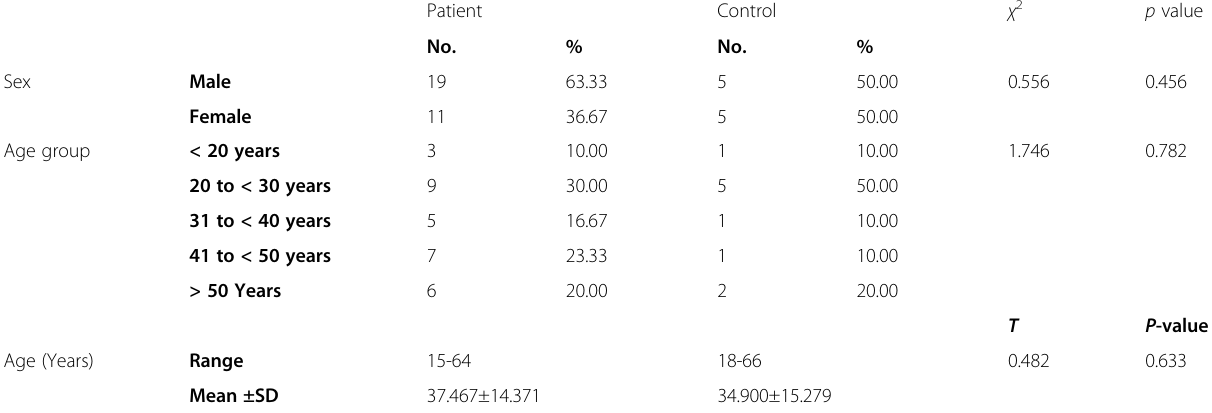
Table 2 Distribution of the studied cases according to demographic data ( n =